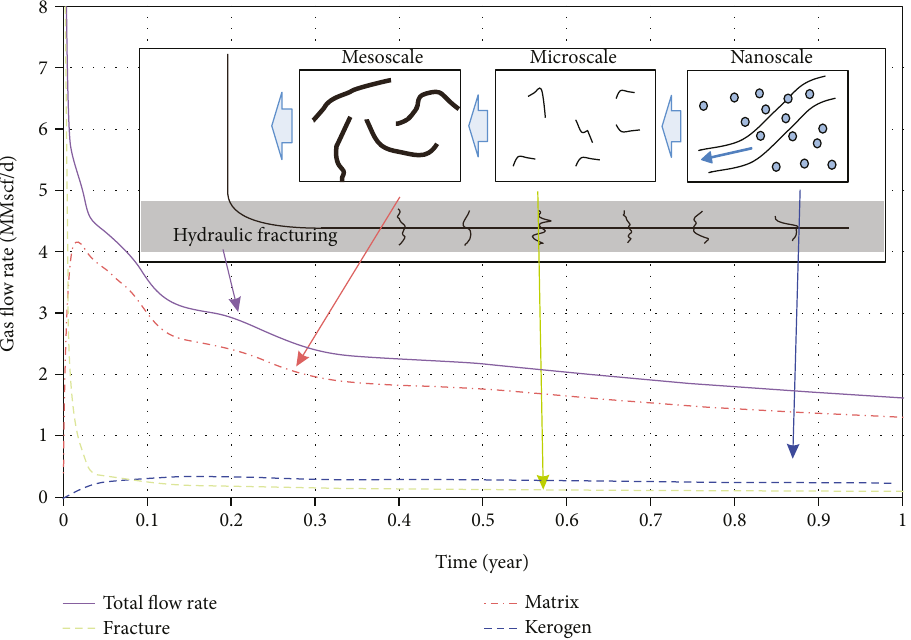
Figure 4: Gas fl ow rate curves in di ff erent systems.